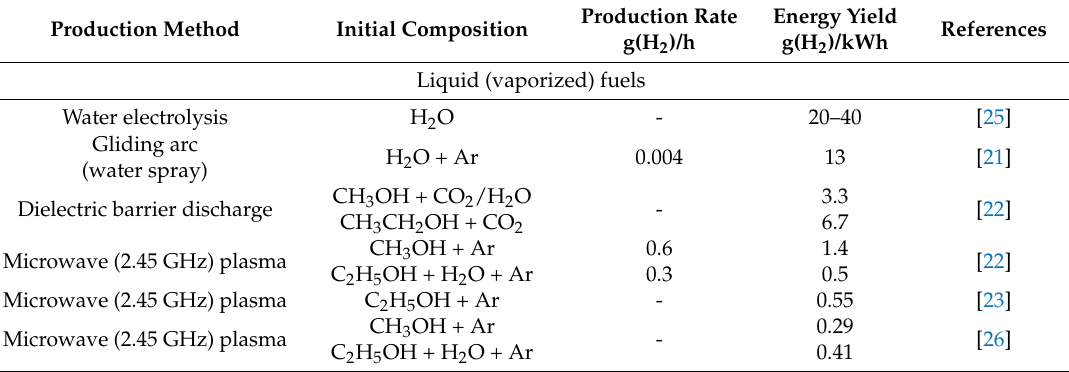
Table 1. Comparison of plasma-based methods of in terms of H 2 production rates and energy yields